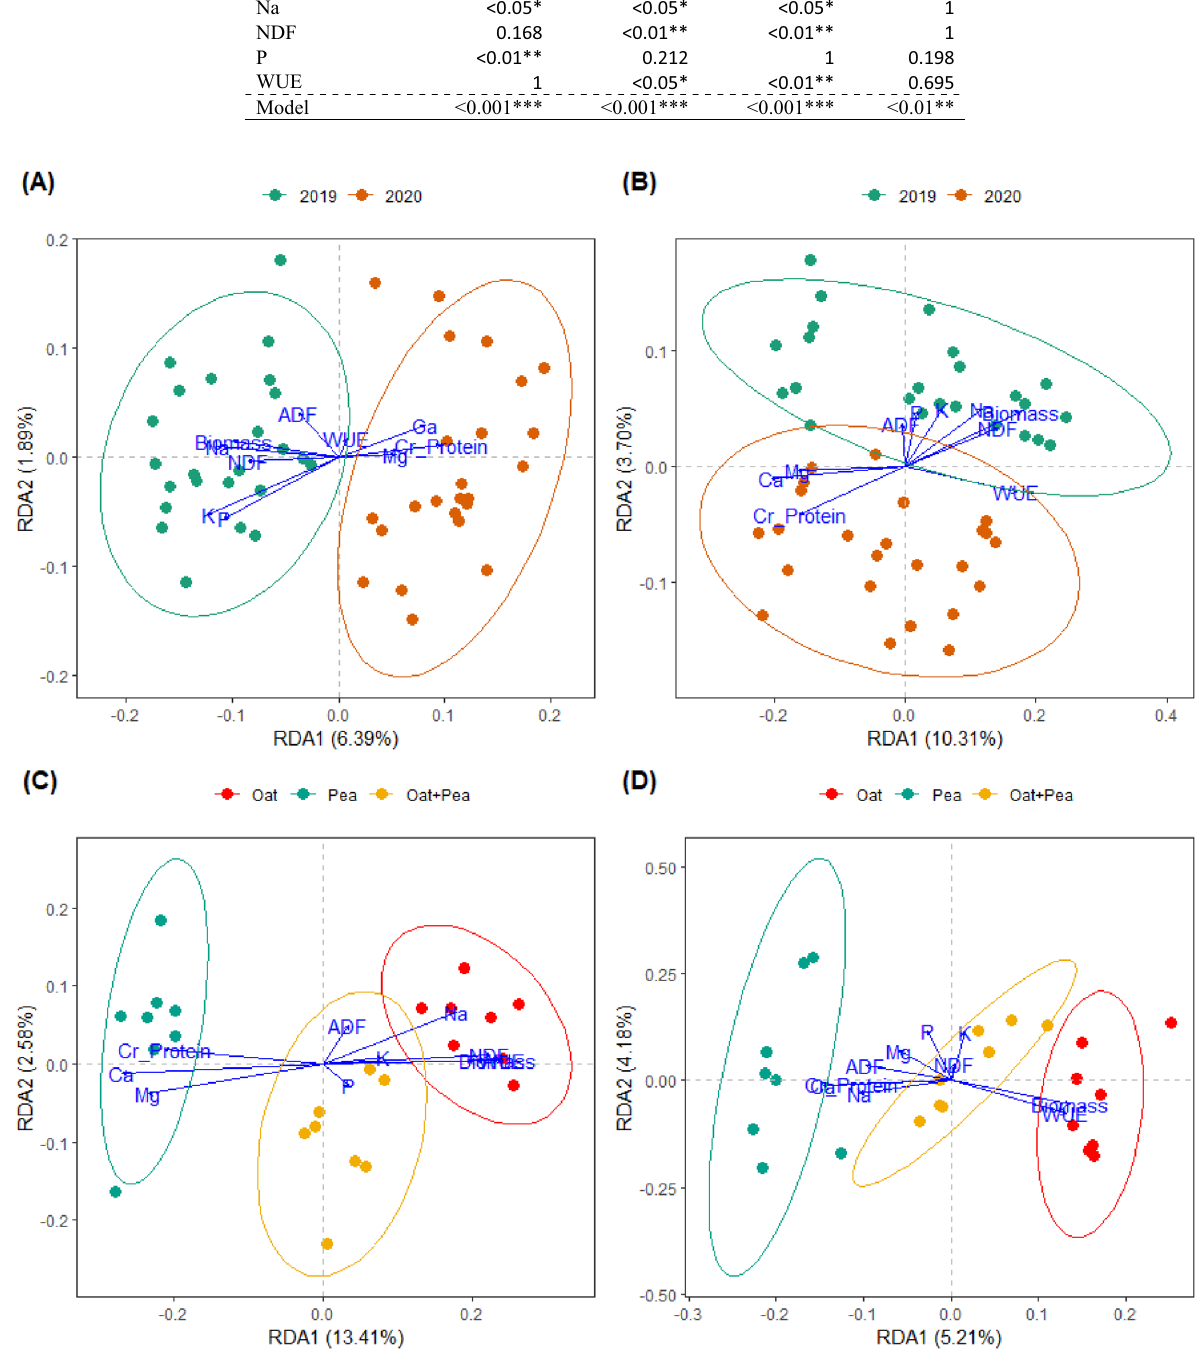
Figure 3. RDA of AMF taxonomic community composition among soil ( A ) and root ( B ) samples for two different years. RDA of AMF taxonomic community compositions across cropping treatments [Oat, Pea, Oat- Pea] in 2019 ( C ) and 2020 ( D